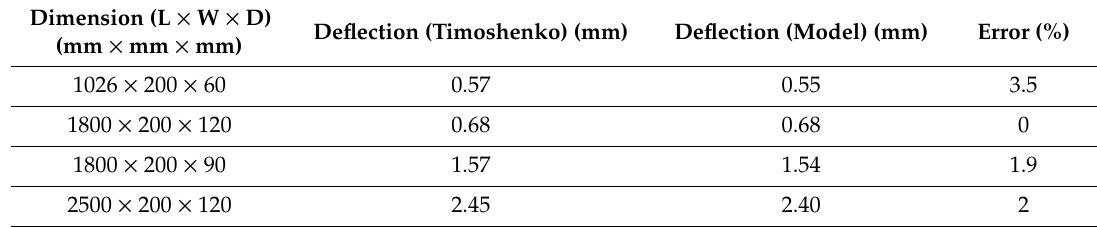
Table 5. Deflection estimated by Timoshenko method and FE models for glue laminated timber